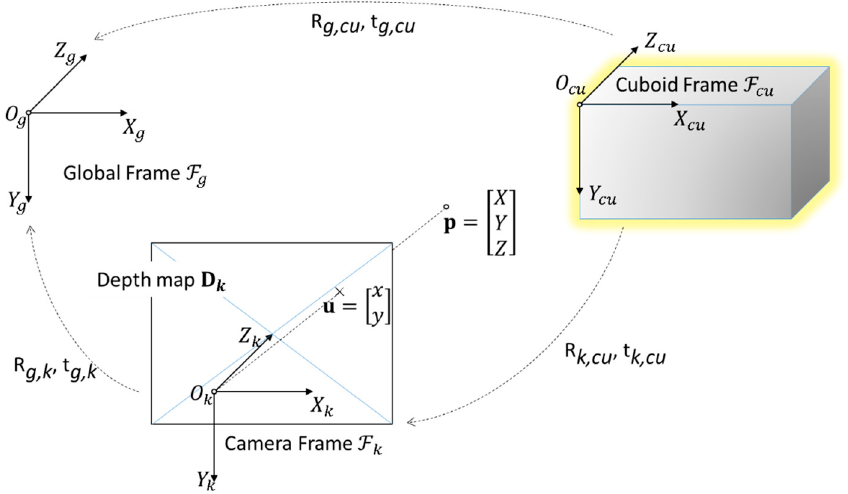
Figure 4. Illustration of the notations used in this paper.